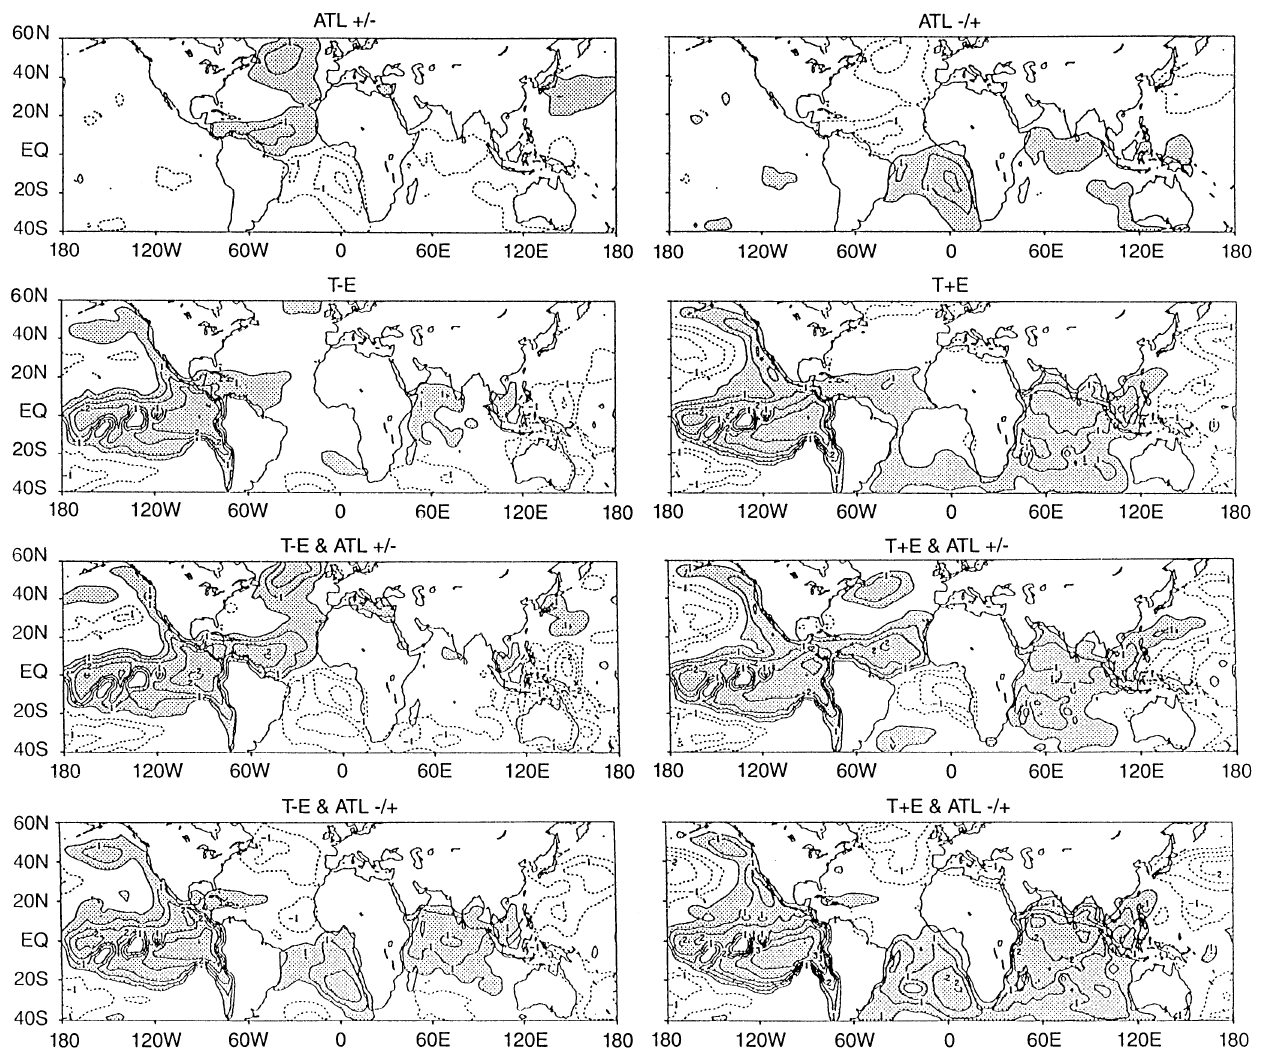
are shaded in grey ; negative anomalies colder than ! 0.1 ° C in white ). Isolines every 0.5 °